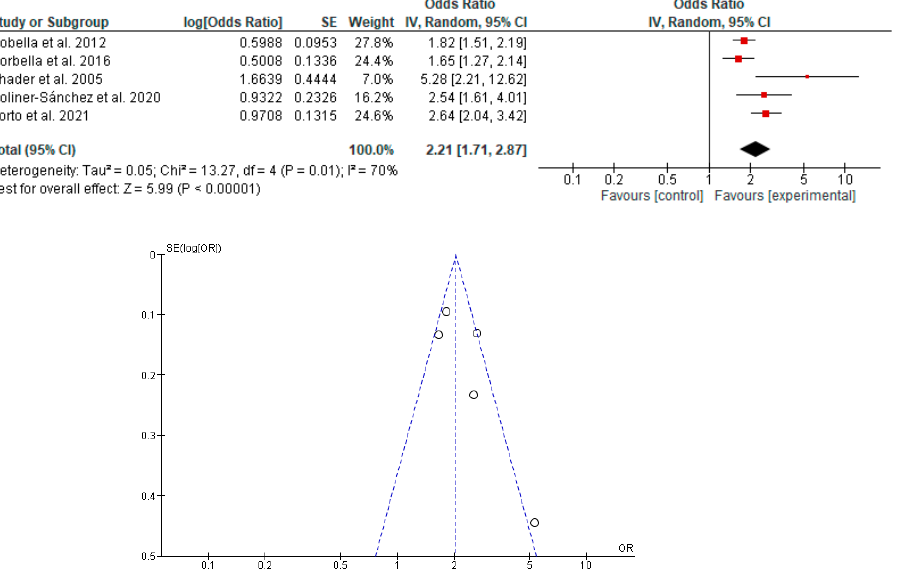
Figure 3. Forest plot and funnel plot of the association between the risk of LBW in newborns with PD in pregnant women.